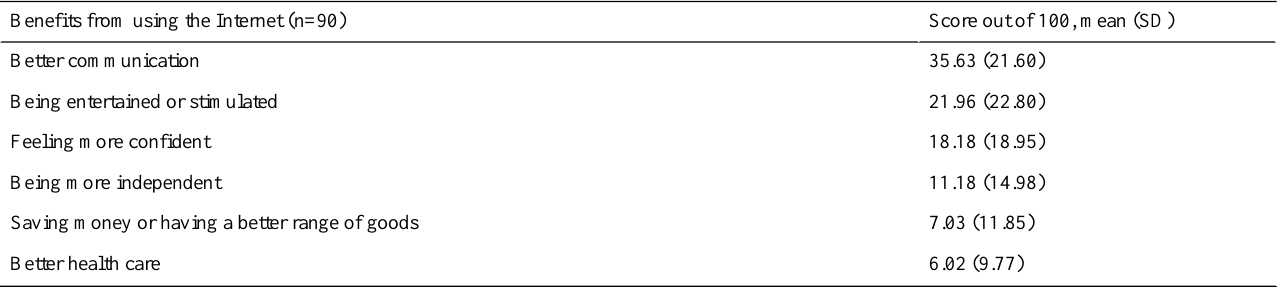
Table 4. Values assigned to personal use of the Internet based on answers to question 1 from the Value of Participation postal survey: Have you benefited from using the Internet in any of these ways?